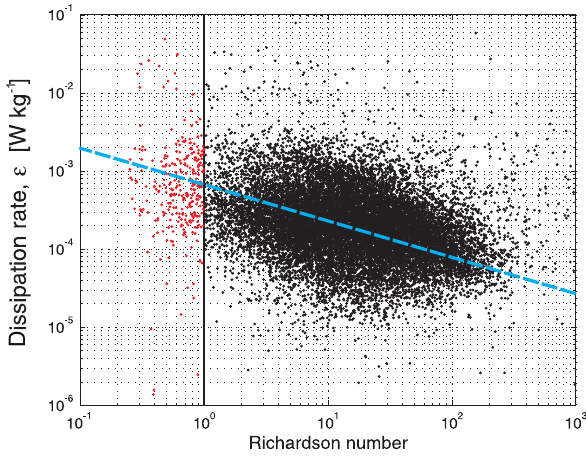
Figure 12. Scatter plot of energy dissipation rates ε derived from the radar measurements with MAARSY vs. the Richardson number in logarithmic scales in the years of 2010–2013. Both data sets are analysed with a height resolution of 300m. All values at the condi- tion of Ri < 1 ( Ri > 1) are marked in red (black). The Ri = 1 line is indicated in black. The dashed line indicates an expected linear anti-correlation between the two quantities